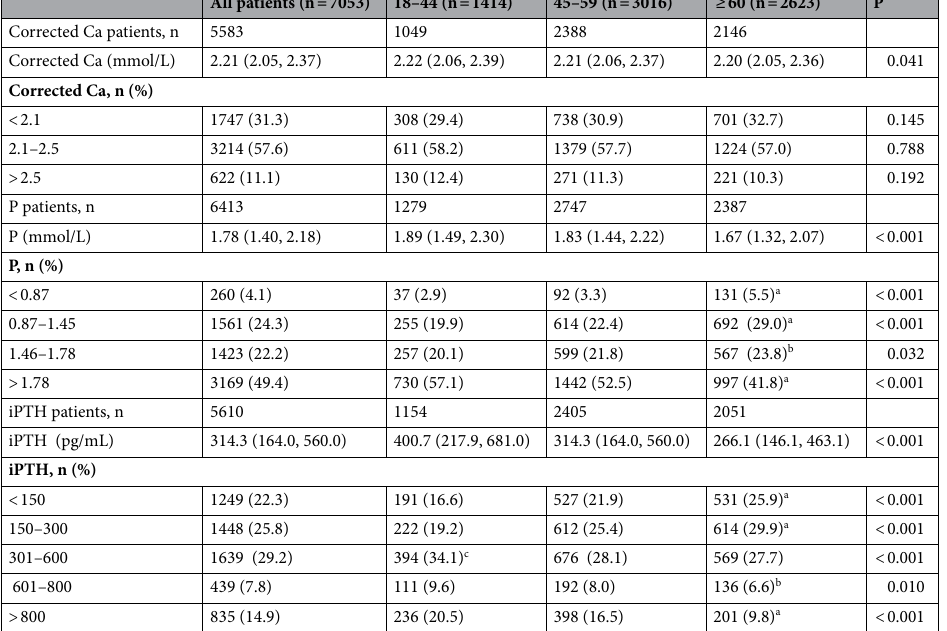
Table 5. The levels of Ca, P, and iPTH in different-age groups. a Patients over 60 years old compared with the other two age groups, P -int < 0.05. b Patients over 60 years old compared with patients under 45 years old, P -int < 0.05. c Patients under 45 years old compared with the other two age groups, P -int <